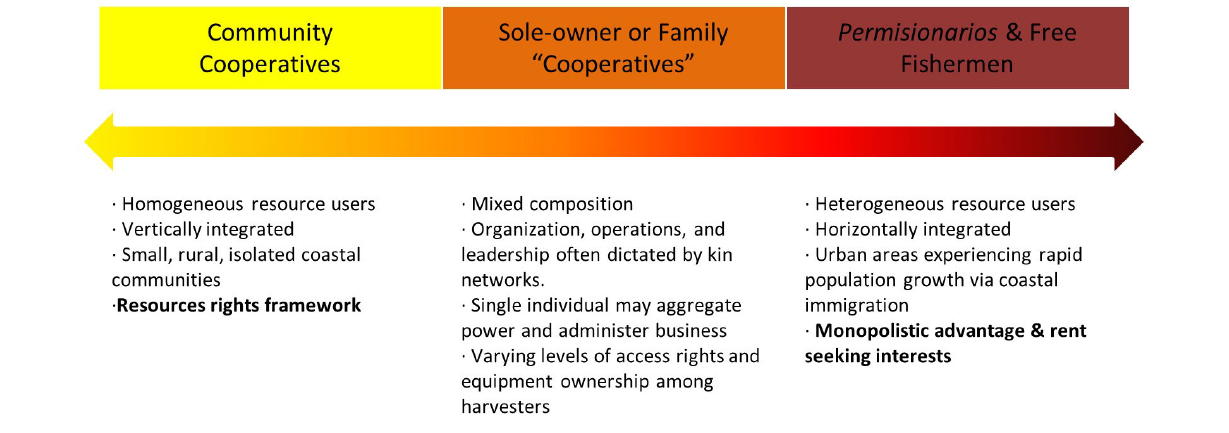
Fig. 1 . Small-scale fisheries organizational continuum across northwest Mexico. Although community cooperatives targeting high-value, benthic species, i.e., lobster and abalone, are common across the Pacific Northwest, following several decades of neoliberal reform the labor of free fishermen within the Gulf of California is largely organized via a network of private permit holders ( permisionarios